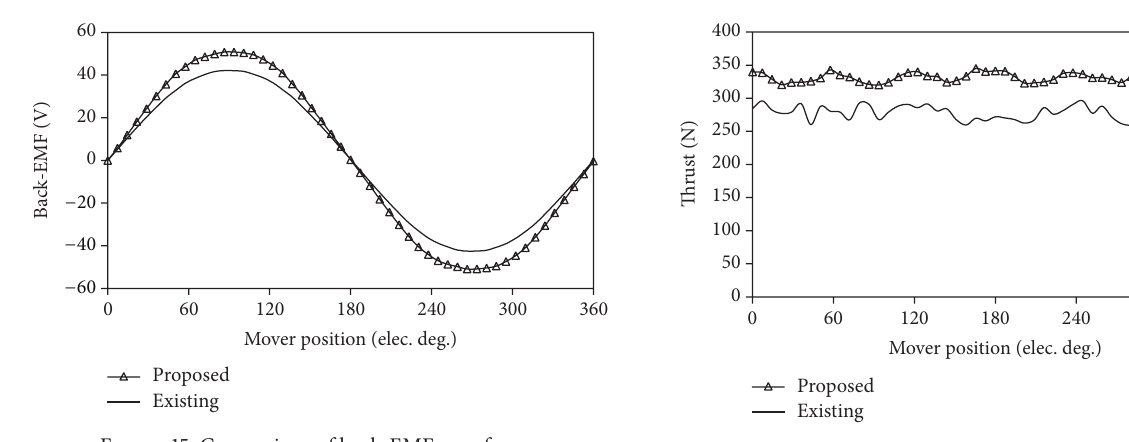
Figure 15: Comparison of back-EMF waveforms.